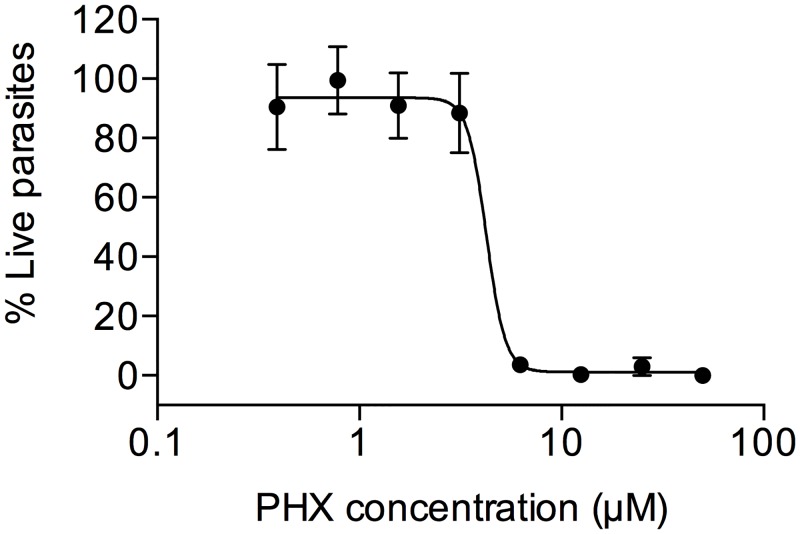
Survival of S. mansoni schistosomula after in vitro PHX treatment.Schistosomula (100/well) were incubated with serial dilutions of PHX, 5 wells at each concentration. Data, evaluated 24 hours post treatment, were normalized based on 50 μM GA-treated control (0% survival) and DMSO treated schistosomula (100% survival) values at each time point as described in methods. The error bars represent the SEM. The LD50 was 4.25.